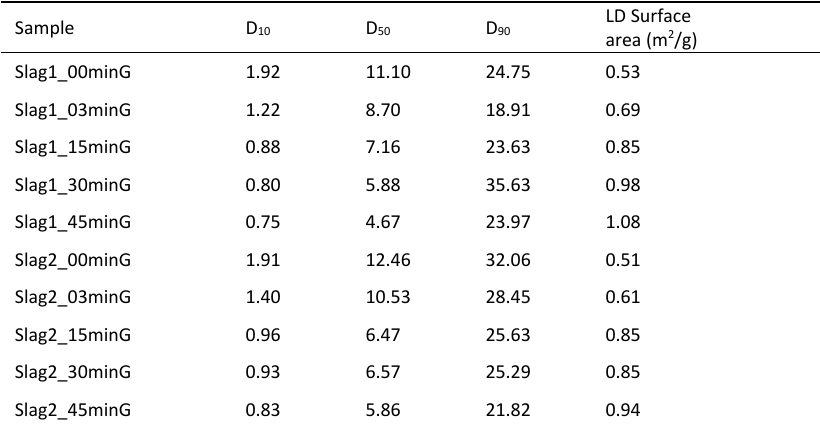
Table 2. The D 10 , D 50 , D 90 and LD surface areas of type 1 and type 2 slags.